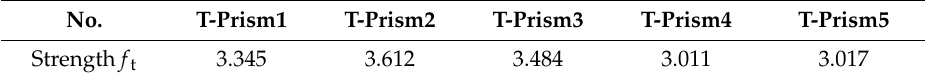
Table 2. Tensile strength f t of prismatic specimens